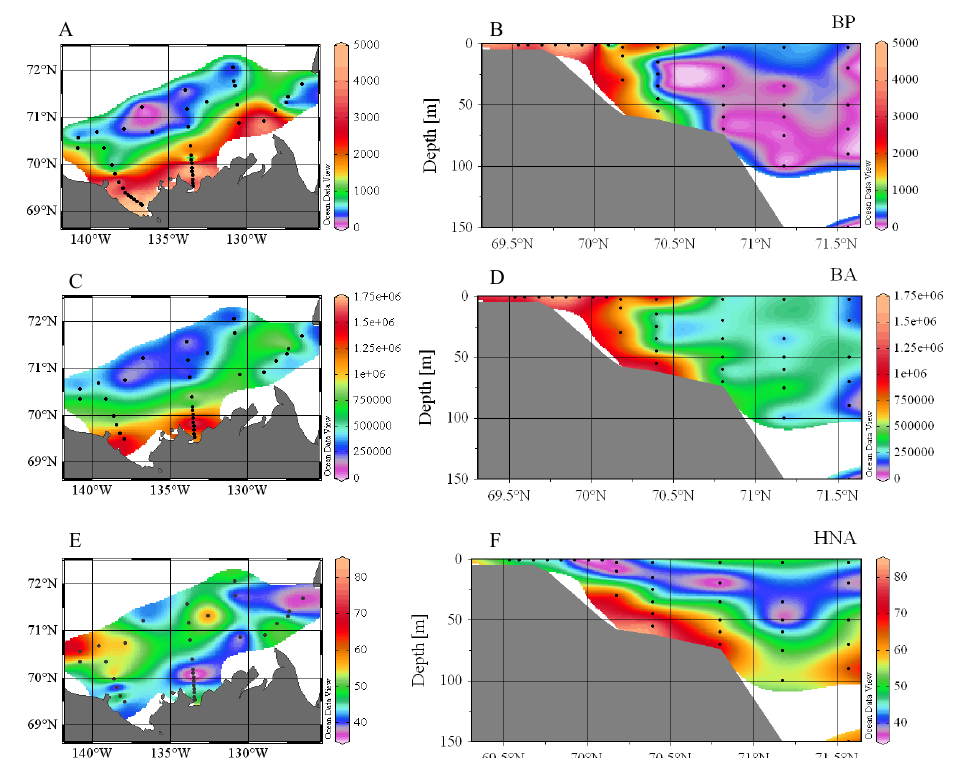
Fig. 2. Surface values (left panels) and vertical profiles belonging to transect 300 from river to sea (right panels) of bacterial production